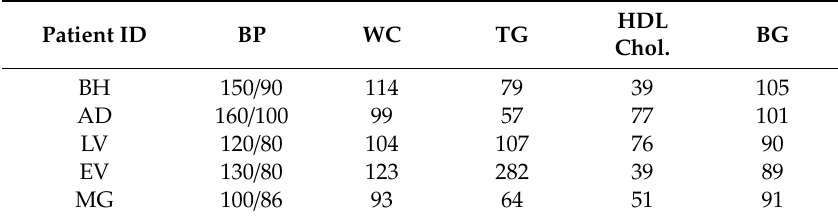
Table 4. Baseline data from five MetS patients with 4 / 5 CVD risk factors. The shadowed cells indicate the conditions under treatment.